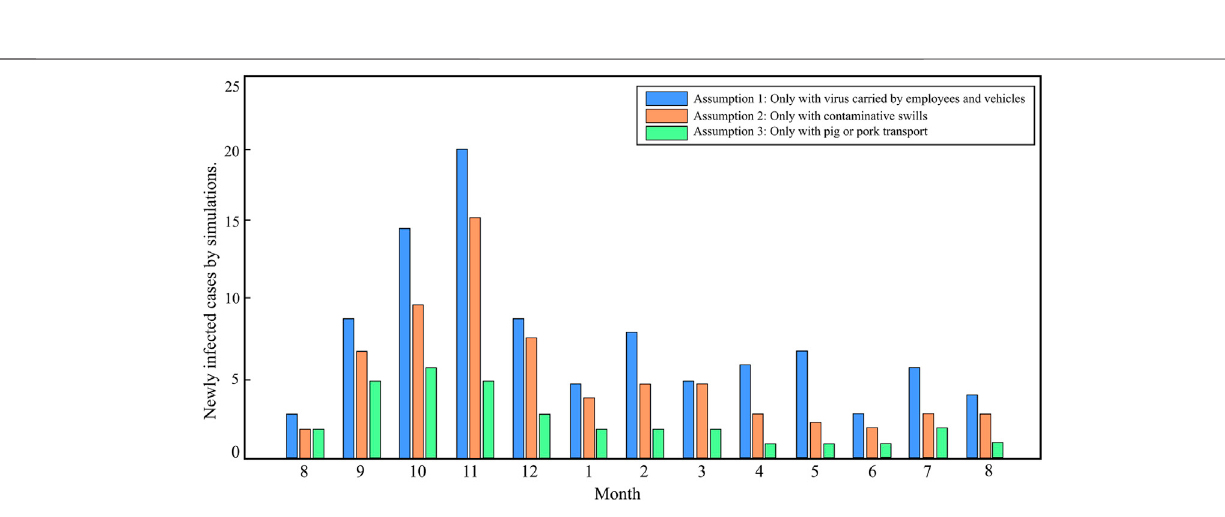
FIGURE 8 | Newly infected cases with time by simulations under the assumption that only one transmission route works.